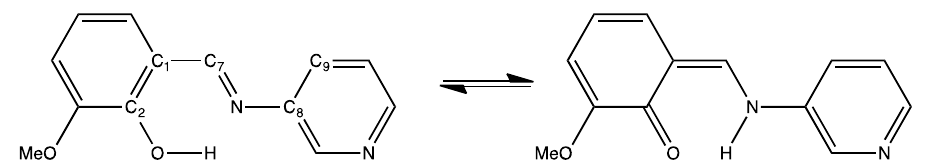
Figure 1. Structure and keto–enol equilibrium of the studied salicylideneaniline: (E)-2-methoxy-6- (pyridine-3-yliminomethyl)phenol (PYV3). Key bonds and atoms characterizing the geometries are highlighted on the enol structure.